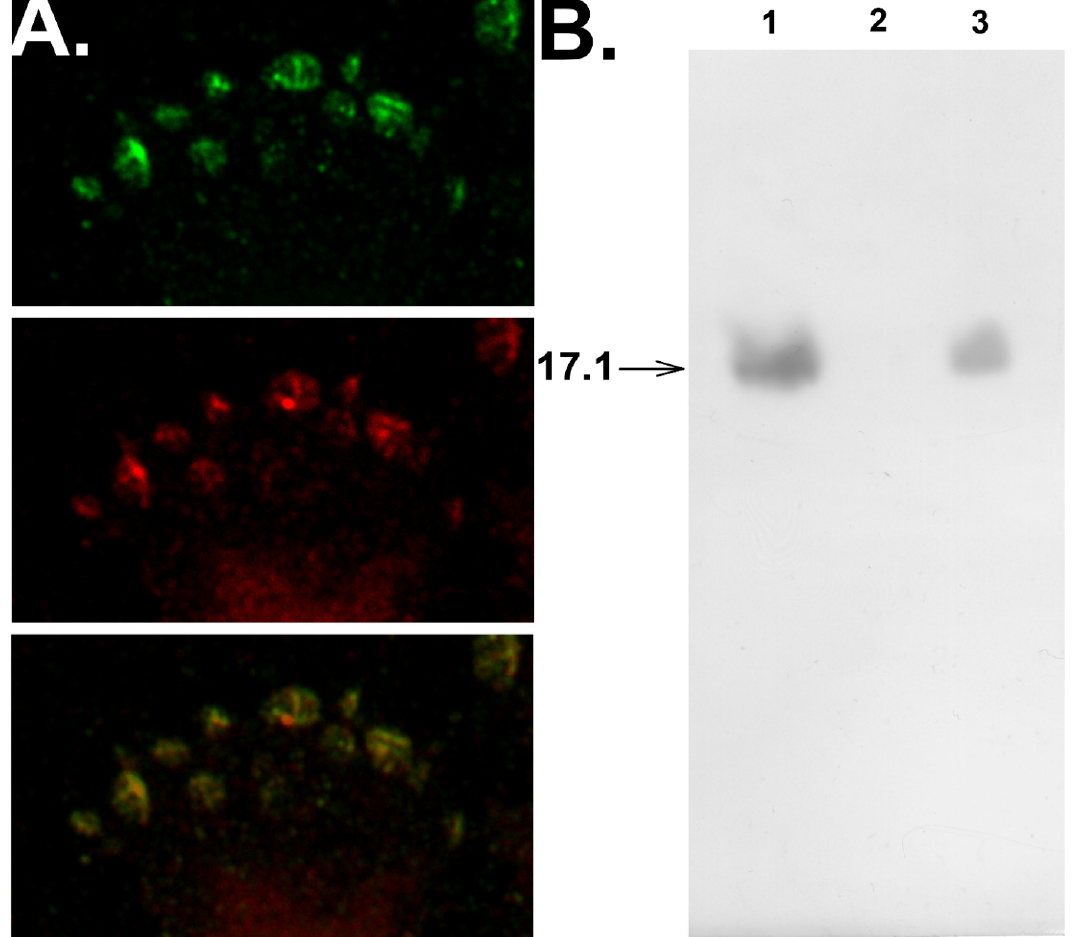
Figure 3. Peptide 17.1 binds to TNFR1 on the cell surface and competes for binding with TNFR1 in solution. ( A ) Confocal photograph of the surface of L929 cells after incubation with 17.1 peptide for 30 min, stained with anti-Tag7 antibodies (green), anti-TNFR1 antibodies (red), and image superposition. ( B ) Western blot analysis of 17.1 peptide (1), applied to the sTNFR1 conjugated Sepharose column and then excessively washed with PBS (2) and with TNF α protein (100 × excess) (3). The replacement of peptide 17.1 from its complex with sTNFRI caused by 100-fold excess of TNF